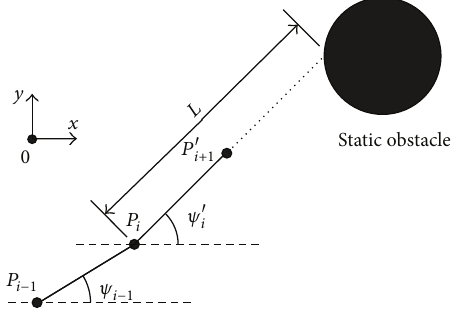
Figure 1: Schematic diagram of static obstacles avoidance for UUV.